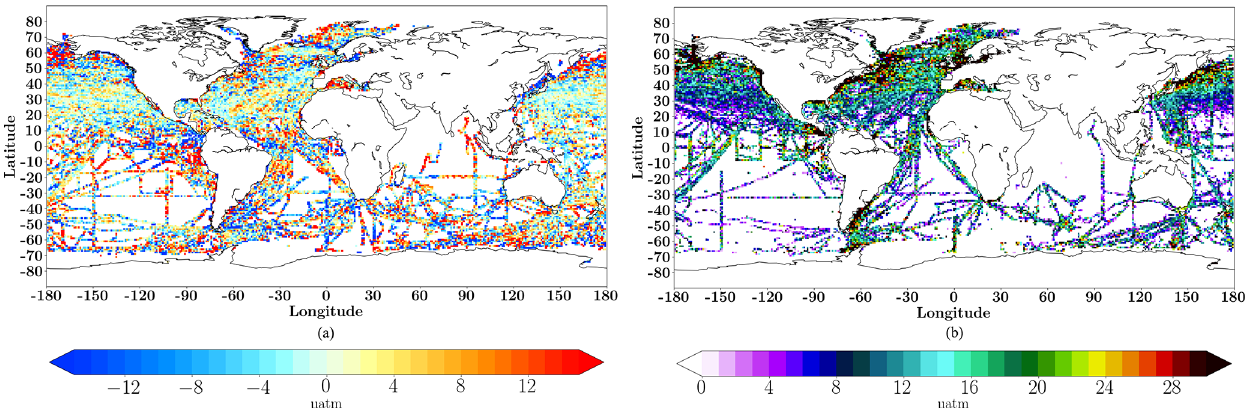
Figure 2. Time mean differences (µatm) between monthly LSCE-FFNN p CO 2 and SOCAT p CO 2 data used for evaluation of the model over the period from 2001 to 2016 (a) and its standard deviation (b) .